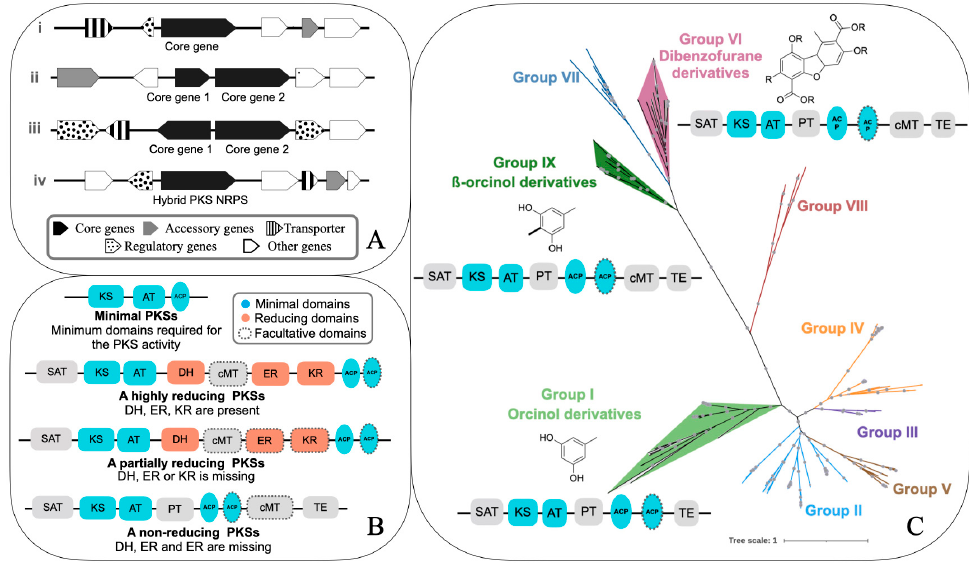
Figure 1. Biosynthetic gene clusters, types of PKSs (based on domains), and the evolutionary relationships of non-reducing PKSs. ( A ) Different kinds of biosynthetic gene clusters, depending upon the core genes: (i) a cluster containing a single core gene—this could be a type-I NRPKS (usually 5000–8000 bp) or a type-III NRPKS (~800–1300 bp), an NRPS (~3000–4000 bp), terpene (~800 bp), indol (800–1300 bp), or ribosomally synthesized and post-translationally modified peptides (RiPP, 600–900 bp) BGC; (ii) a cluster containing two core genes—this could be an NRPKS and a reducing PKS, or both reducing PKSs, or both NRPKSs; (iii) a BGC with two core genes in the opposite orientation; (iv) a hybrid BGC with both an NRPS and an NRPKS. ( B ) Domain composition of minimal PKSs, highly-reducing PKSs, partially-reducing PKSs, and non-reducing PKSs. Dotted borders denote that the domain is facultative. ( C ) A representative 1000-bootstrap maximum-likelihood NRPKS tree, showing the nine NRPKS groups. Colored clades represent the groups containing the PKSs, linked to a molecule. The structure of the molecules coded by these clades and the domains of the corresponding PKS are shown in the figure (R = C n H n ). (adapted from Singh et al. 2021 [15]; dataset downloaded from supplemental material Table S2, for details on the dataset, alignment and tree annotation please refer to Singh et al. 2021 [15]). The final data set consisted of amino acid sequences of 229 NR-PKSs from 18 species belonging to five LFF genera- Dermatocarpon , Cladonia , Pseudevernia , Stereocaulon , and Umbilicaria .